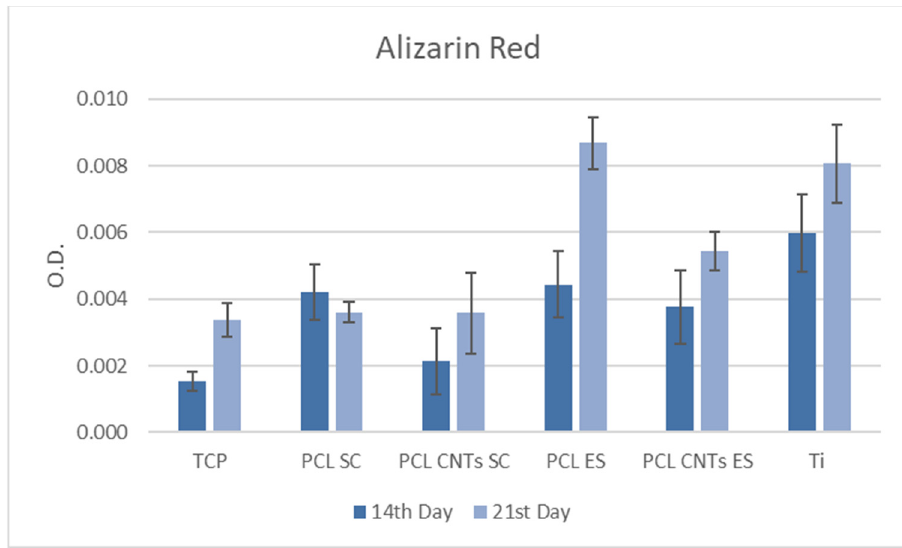
Figure 10. Quantity alizarin red test at 14 and 21 days of incubation on substrates.